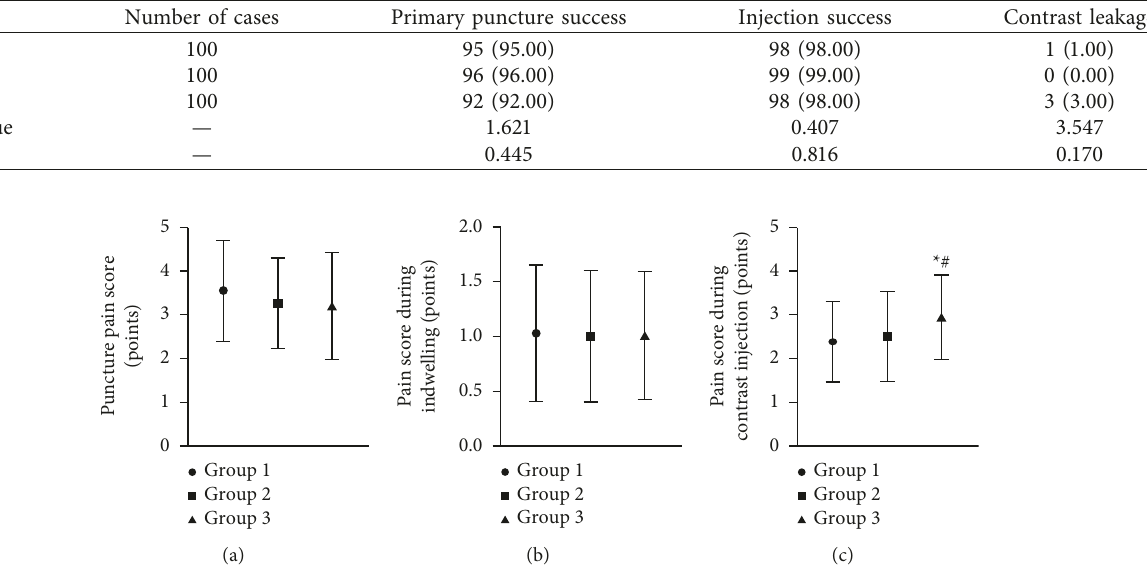
Figure 1: Comparison of pain scores among the three groups of patients ( n � 100, x ± s , x ). Note: ∗ group 1 compared with group 3, P < 0 . 05; #group 2 compared with group 1, P < 0 . 05. (a) The comparison of pain scores during puncture in the three groups; (b) the comparison of pain scores during retention in the three groups; (c) the comparison of pain scores during contrast injection in the three groups. Table 3: Comparison of subjective ratings of image quality among the three groups of patients ( n , %). Group